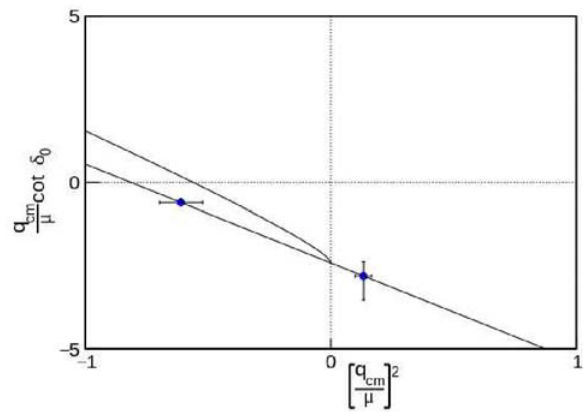
Figure 15. Very preliminary results for the Σ π scattering phase shift near the Λ (1405) resonance against the center-of-mass mo- mentum as ratio with a reference energy μ . Result are from Ref. [18].